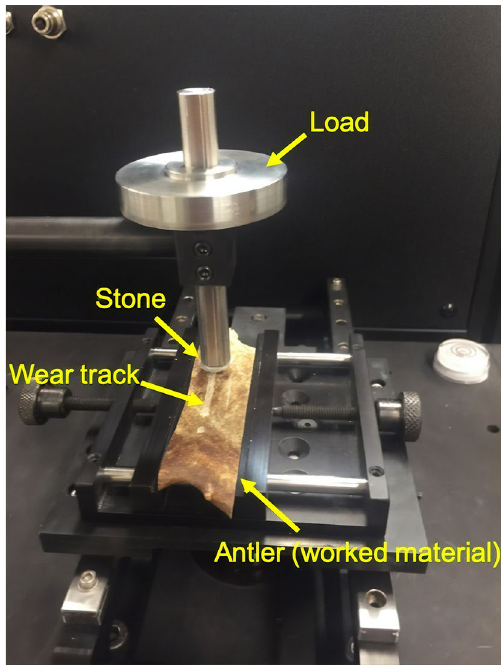
Figure 1. A typical tribology experimental setup highlighting antler as the worked material. The pin bearing the load (5 N shown here, 20 N used in the experiment) travels back and forth on the worked material to generate the wear track on the worked material and polish on the stone (chert). Photo by Kaushik